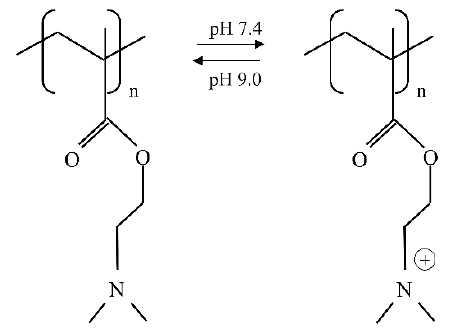
Scheme 1. Protonated and deprotonated formulas of